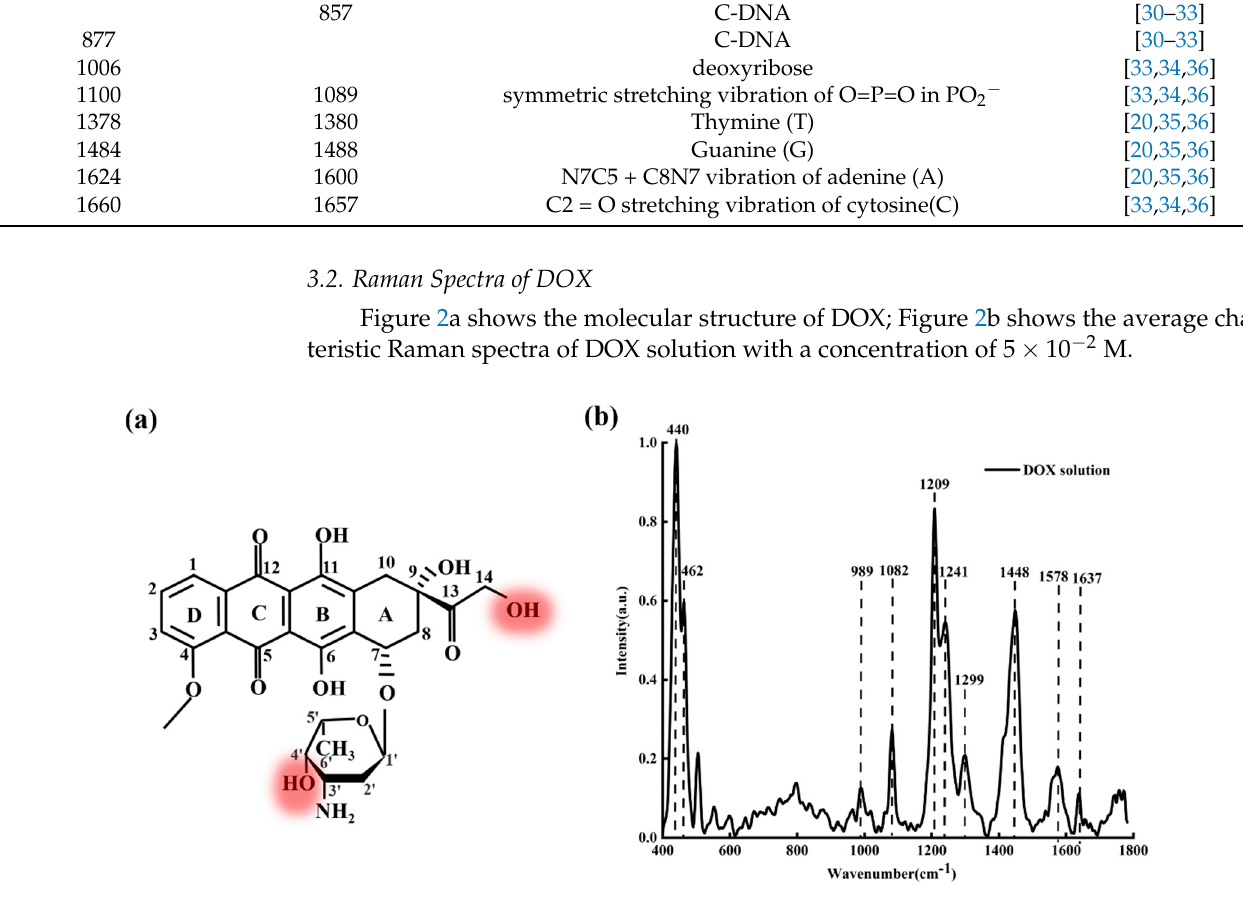
Figure 2. ( a ) The molecular structure of DOX and ( b ) Raman spectra of DOX solution ( 5 (cid:3400) 10 (cid:2879)(cid:2870) M ).